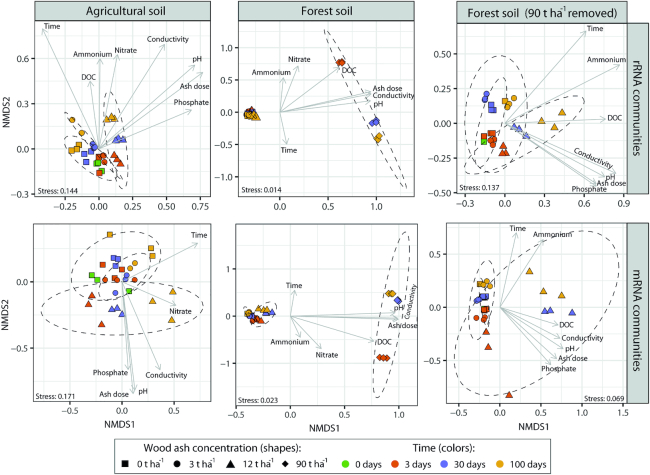
NMDS plots based on Bray–Curtis dissimilarities of the taxonomic (rRNA; top row) and functional (mRNA; bottom row) profiles of an agricultural soil and a forest soil amended with wood ash. Dashed lines represent 95% confidence ellipses around samples with same wood ash concentration. Arrows indicate the direction of fitted physicochemical parameters (using envfit function; only significant parameters shown) onto the NMDS ordination space (longer arrows indicate better fit). To improve the resolution of the forest soil at wood ash concentrations 0–12 t ha−1, we removed the 90 t ha−1 samples and repeated the analysis (rightmost two panels).